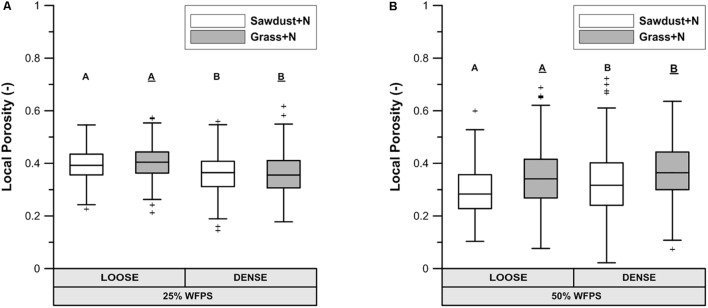
X-ray μCT visible porosity in 350 μm buffer zone around sawdust or grass substrate particles for both loose and densely structured soils at 25% WFPS (A) and at 50% WFPS (B), termed ‘local porosity’. Statistically different means between both established soil structure treatments per substrate are indicated by different capital letters: plain uppercase letters for the sawdust+N and underlined uppercase letters for the grass+N treatments.